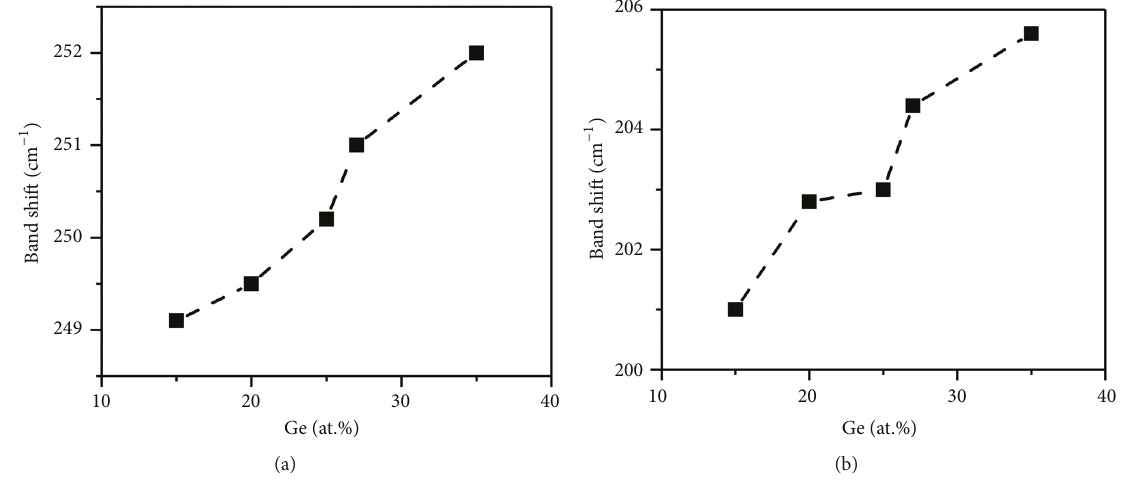
Figure 7: Shift of the bands at 250 cm - 1 (a) and 200 cm - 1 (b) with variation of x value.